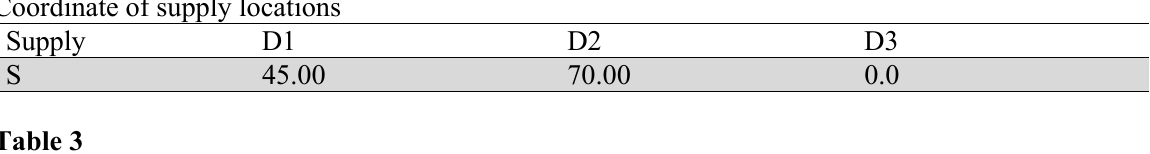
Repeat lifting of material for pair S-D